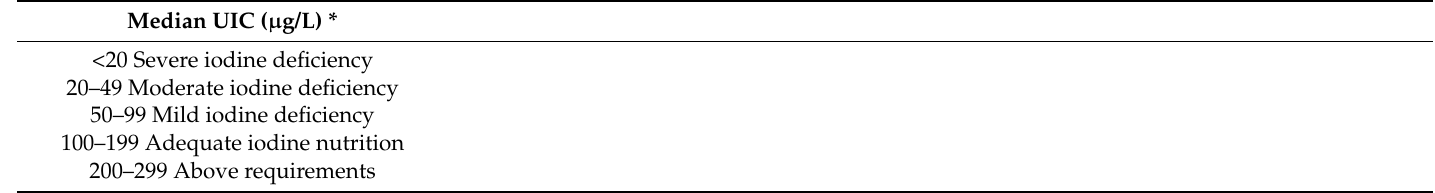
Table 3. Categorization of iodine deficiency according to WHO